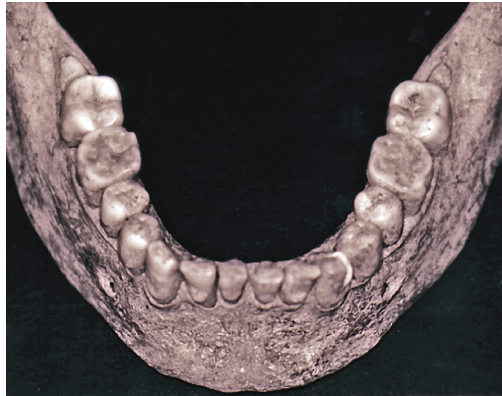
Figure 2: Severe tooth wear on the mandibular first molars in an approximately 20-year-old individual from the 16th century (third molars are impacted). Looking carefully, NCCLs can be seen indi- cating either abrasive or erosive influences, which, in combination with the wear seen on the first molars, resembles the pattern seen in modern erosive wear